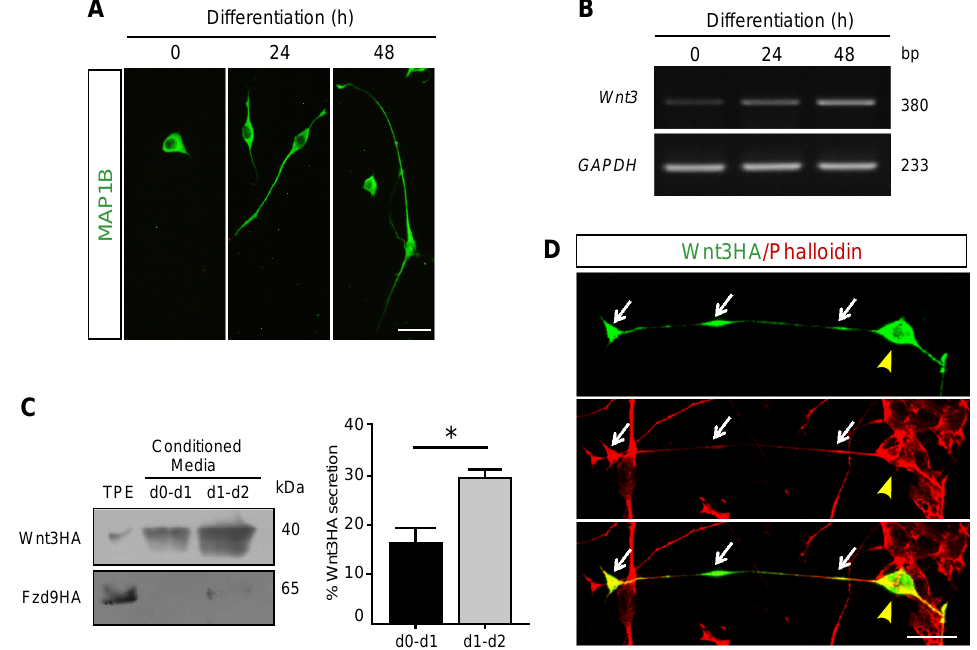
Figure 1. Wnt-3 is expressed and secreted by NSC-34 cells. ( A ) NSC-34 cells were cultured in growth medium and differentiated in Neurobasal medium for 24 or 48 h. Fixed cells were subjected to indirect immunofluorescence for MAP-1B. Bar, 30 µ m. ( B ) Total RNA was obtained from NSC-34 cells at different times of differentiation and Wnt3 mRNA levels were analyzed by conventional RT-PCR. As loading control GAPDH was amplified. Negative control reactions were performed in the absence of reverse transcriptase (RT-). ( C ) NSC-34 cells were transfected with plasmids coding for Wnt3HA or Fzd9HA. Total protein extracts (TPE, obtained at 48 h) and concentrated conditioned media were subjected to Western blot using an anti HA antibody. A 40 kDa band was detected in TPE and conditioned media of NSC-34 cells expressing Wnt3Hal, whereas a 65 kDa was detected only in the TPE of cells expressing Fzd9HA. The panels on the left show representative band intensity. The plot on the right shows the average ± SEM of the band quantification from three independent experiments (* p < 0.05; t -test) ( D ) NSC-34 cells were transfected with Wnt3HA and stained with an anti HA antibody plus the microfilament marker phalloidin. Arrowheads and arrows indicate Wnt3HA distribution in the cell soma, as well as in neurites and growth cone tips, respectively. Bar, 30 µ